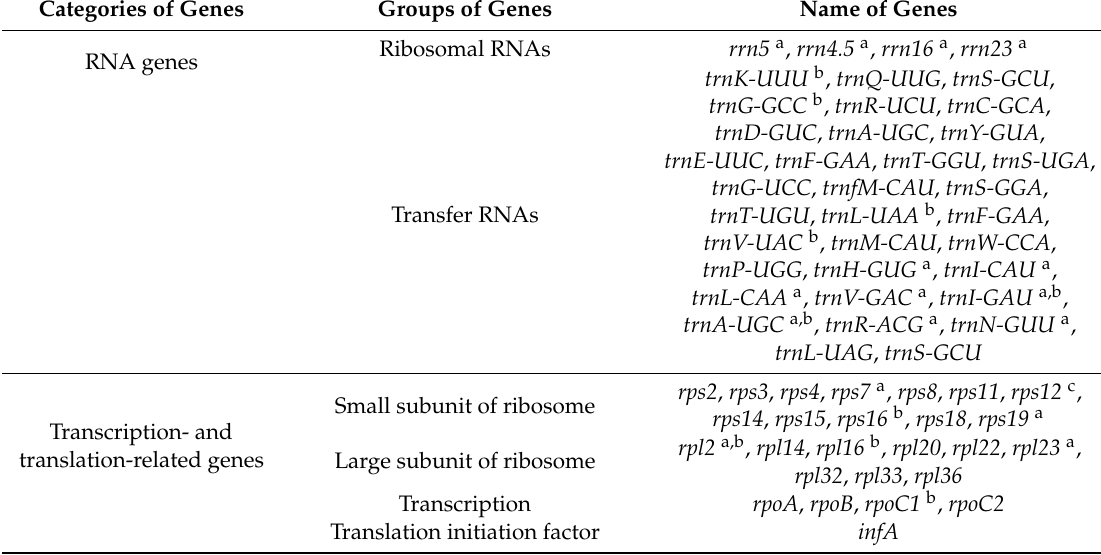
Table 2. Gene Composition of the Coelogyne Chloroplast